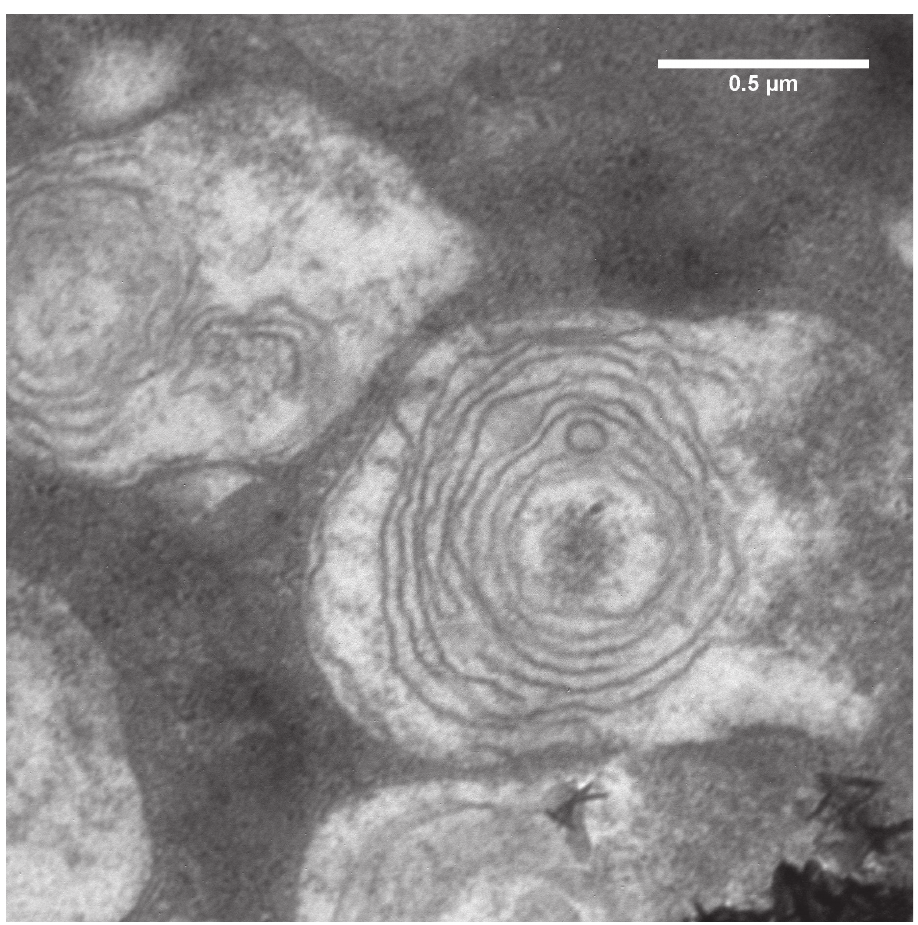
Figure 10. TEM image of the lamellar bodies found underneath the synsternal translucent patch in a Dendrocerus sp. (Hymenoptera: Megaspilidae) Specimen identifier: IM